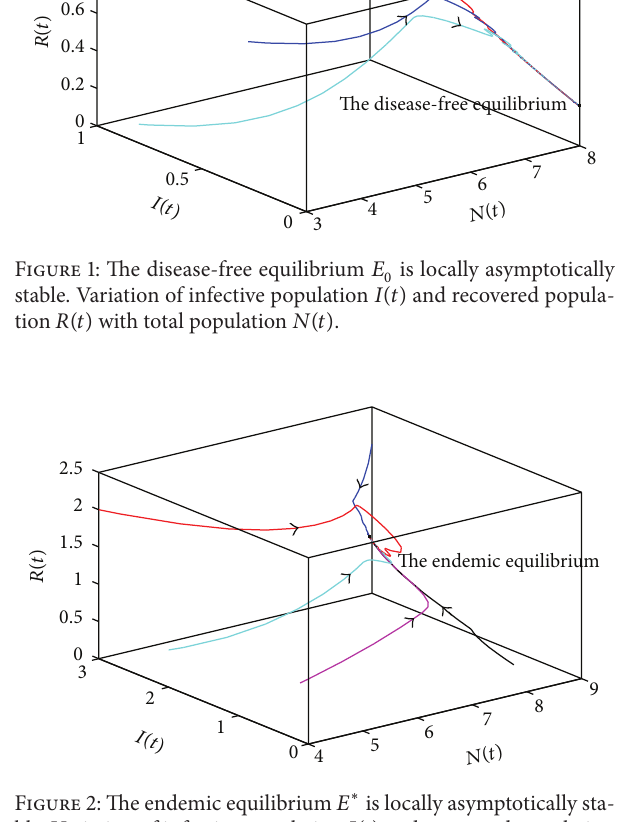
Figure 2: The endemic equilibrium 𝐸 ∗ is locally asymptotically sta- ble. Variation of infective population 𝐼(𝑡) and recovered population 𝑅(𝑡) with total population 𝑁(𝑡) .